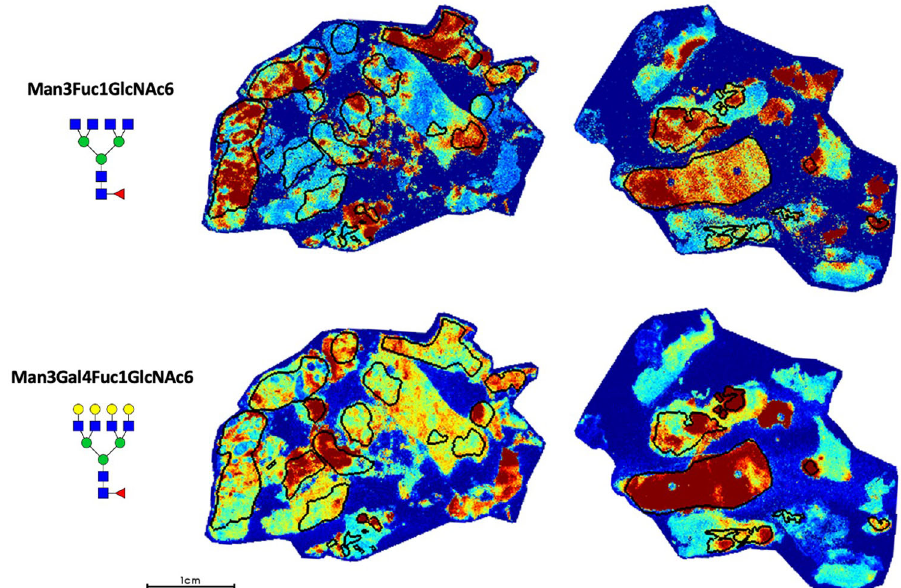
Fig. 5 Representative glycan image demonstrating Man3Fuc1GlcNAc6 (1891.6924 m/z) and Man3Gal4Fuc1GlcNAc6 (2539.9037 m/z) localization within demarcated tumor regions (black circles) in two hormone resistant PCa